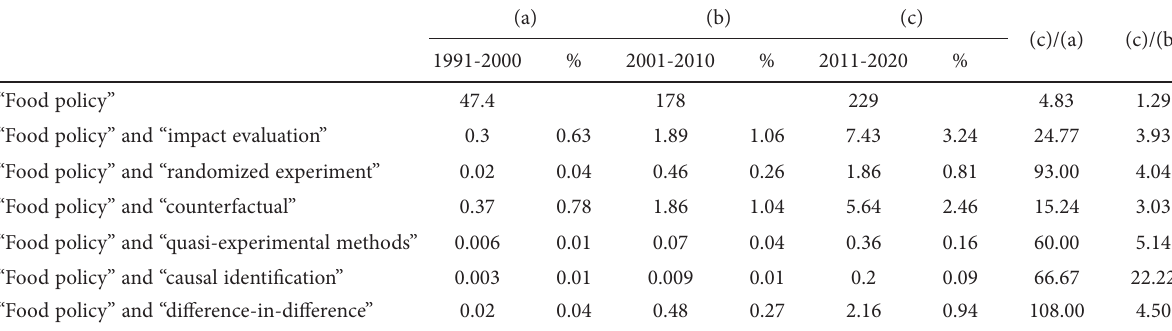
Table 1. Food policy and evaluations in Google Scholar keywords searches over three